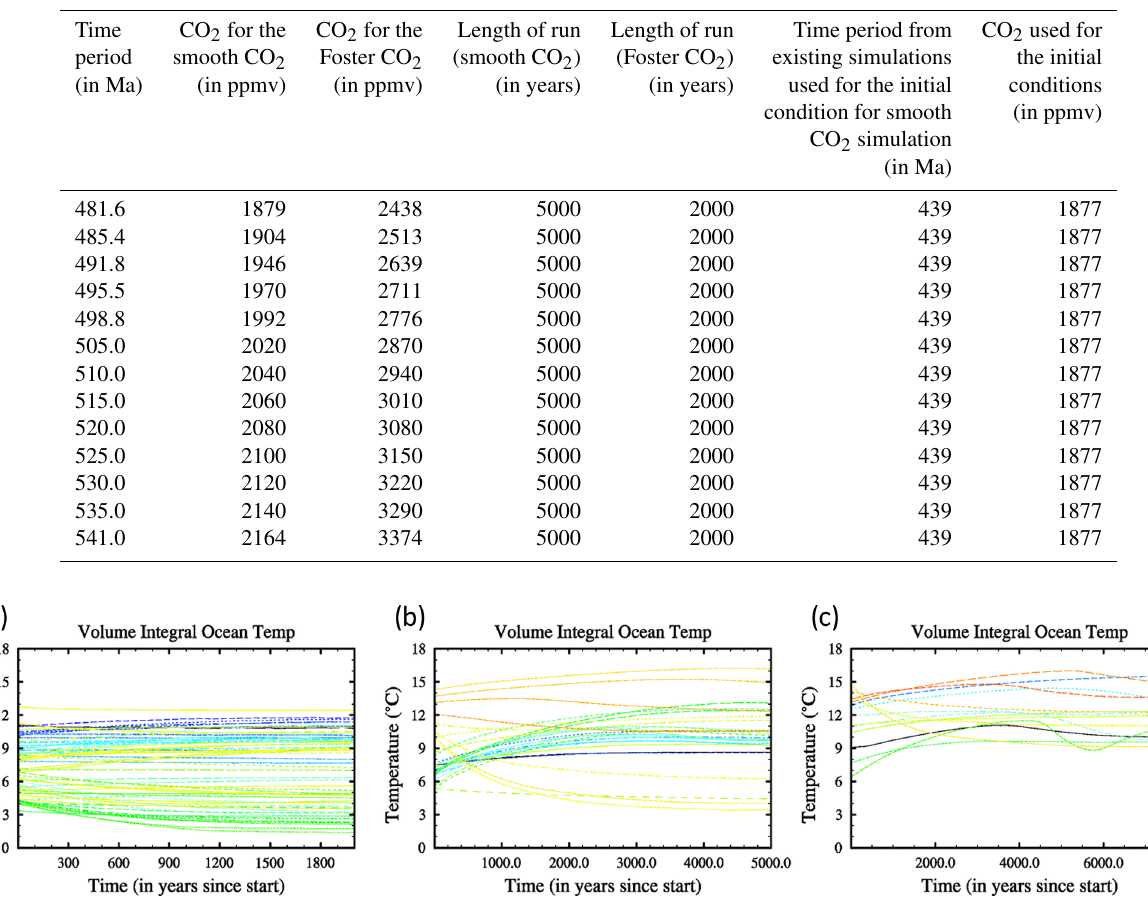
Figure 3. Time series of the annual volume mean ocean temperature for all 109 simulations. Panel (a) shows those simulations for which 2000 years was sufficient to satisfy the convergence criteria described in the text (these were for all simulations listed in Table 1 except those listed in panels b and c ), (b) those simulations which required 5000 years (these were for all the simulations for 31.0, 35.9, 39.5, 55.8, 60.6, 66.0, 69.0, 102.6, 107.0, 121.8, 127.2, 154.7, 160.4, 168.2, 172.2, 178.4, 186.8, 190.8, 196.0, 201.3, 204.9, 213.2, 217.8, 222.4, 227.0, 232.0, and 233.6Ma), and (c) those simulation which required 8000 years (these were simulations for 44.5, 52.2, 86.7, 91.9, 97.2, 111.0, 115.8, 131.2, 136.4, 142.4, 145.0, 148.6, 164.8, and 239.5Ma). The different coloured lines show the different runs. The plots simply show